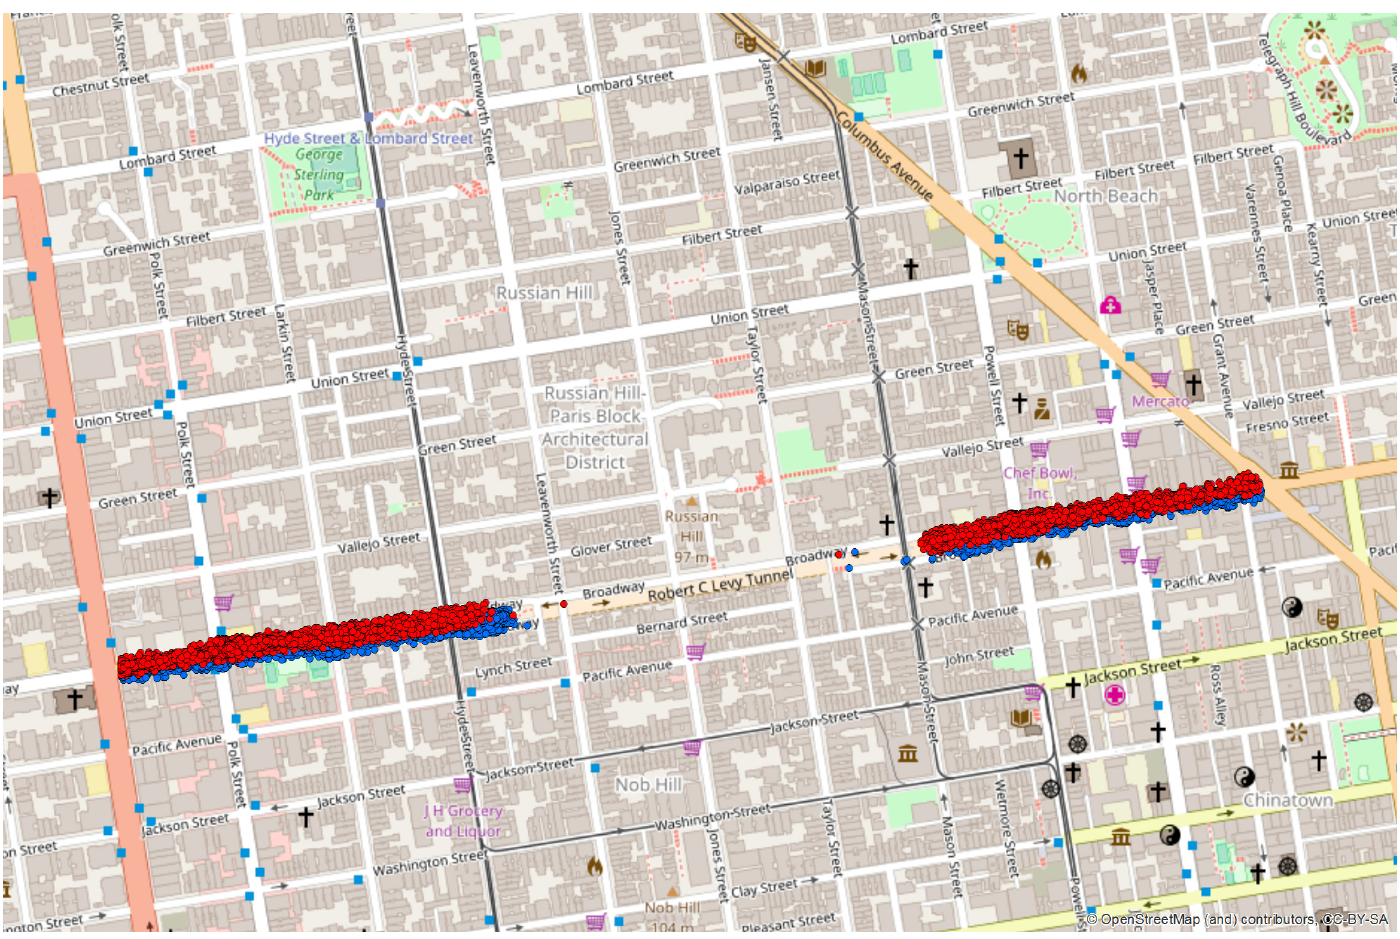
Figure A2. Robert C. Levy (Broadway) Tunnel, São Francisco